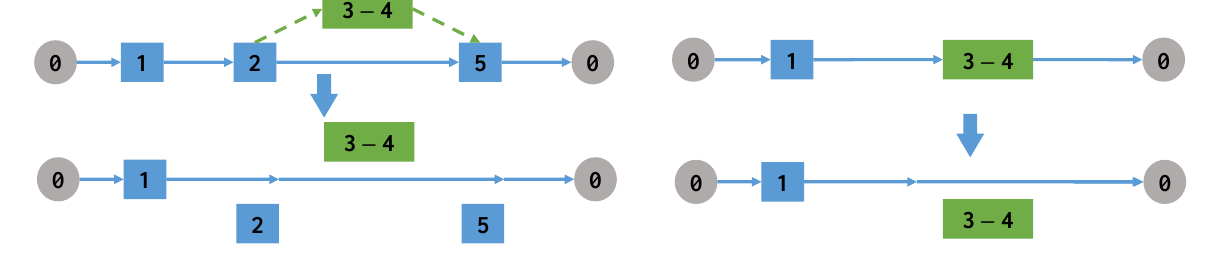
Figure 5. Change the route of the vehicle.